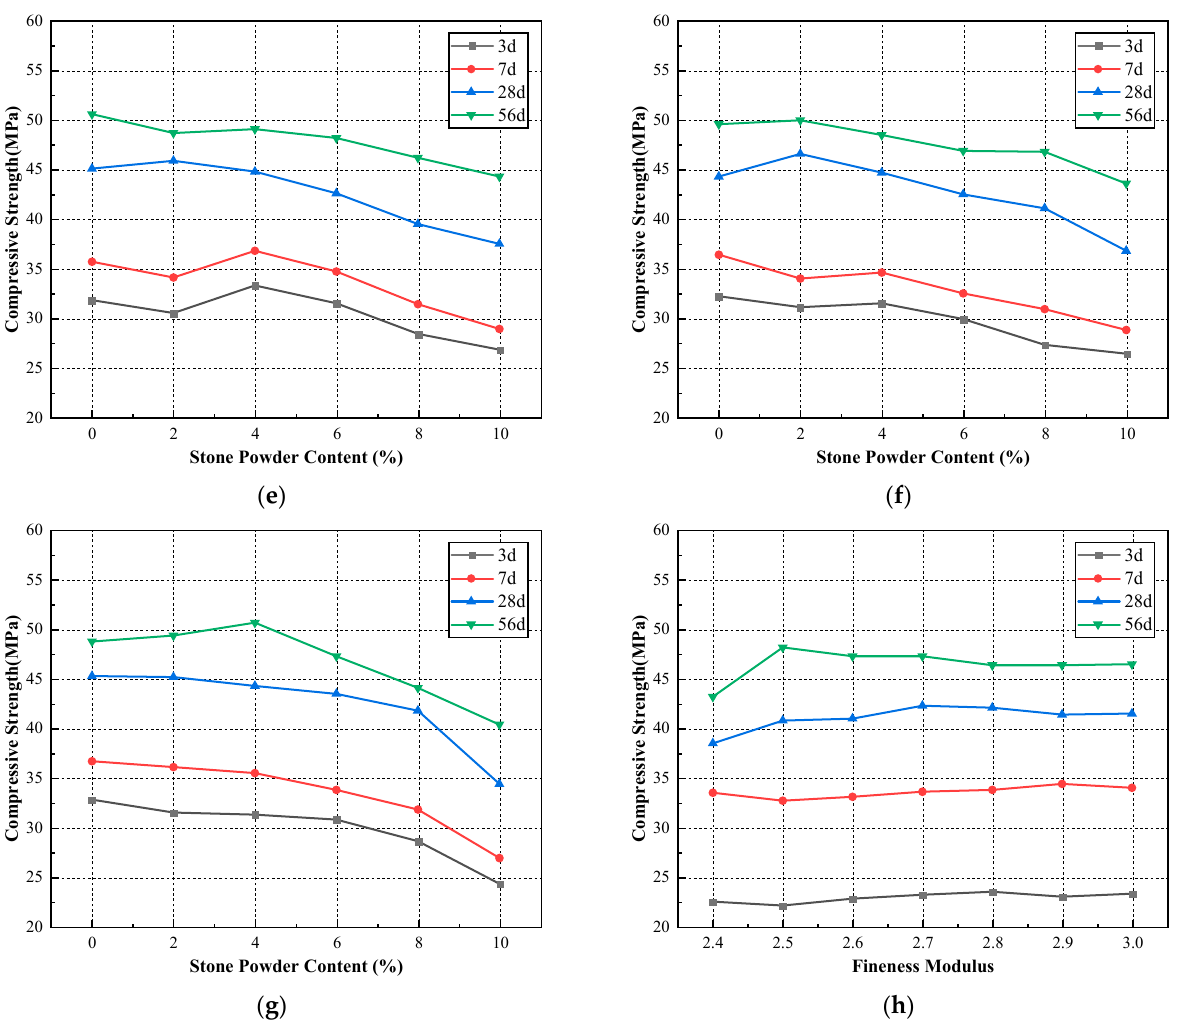
Figure 9. Mechanical properties versus fineness modulus and stone powder content curve: ( a ) fine- ness modulus 2.4; ( b ) fineness modulus 2.5; ( c ) fineness modulus 2.6; ( d ) fineness modulus 2.7; ( e ) fineness modulus 2.8; ( f ) fineness modulus 2.9; ( g ) fineness modulus 3.0; ( h ) river sand concrete.